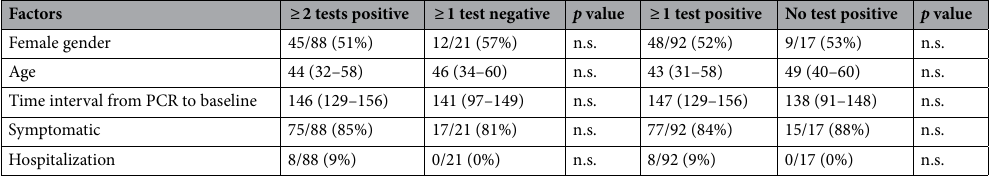
Table 3. Factors not influencing seropositivity at